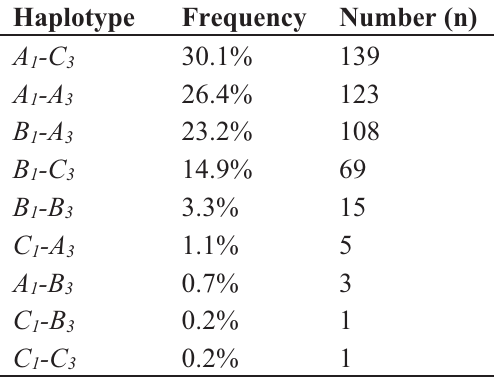
Table 3. ADIPOQ haplotypes and frequencies for the region spanning region-1 to